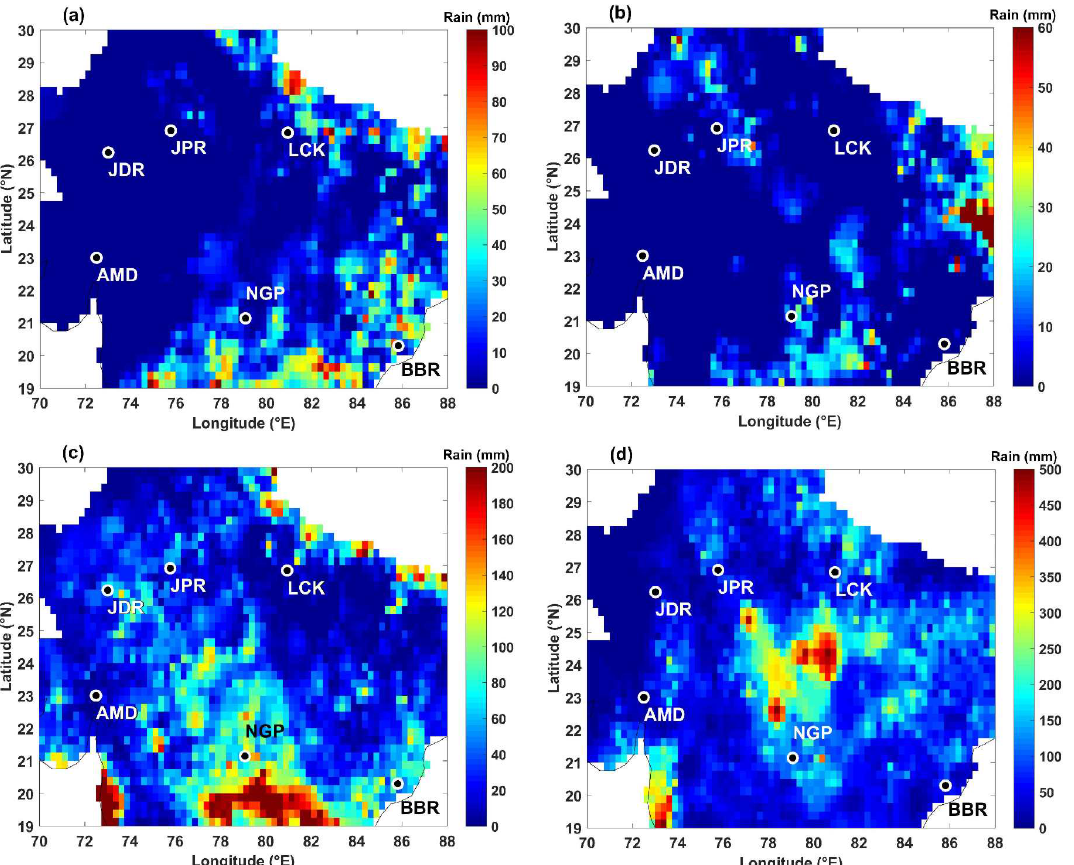
Figure 2. Accumulated rainfall for the periods (a) 4–10 June (1 week prior to Phase 1 measurements), (b) 11–13 June (during Phase 1 measurements), (c) 25 June to 1 July (1 week prior to Phase 3 measurements) and (d) 2–7 July (during Phase 3 measurements of the SWAAMI